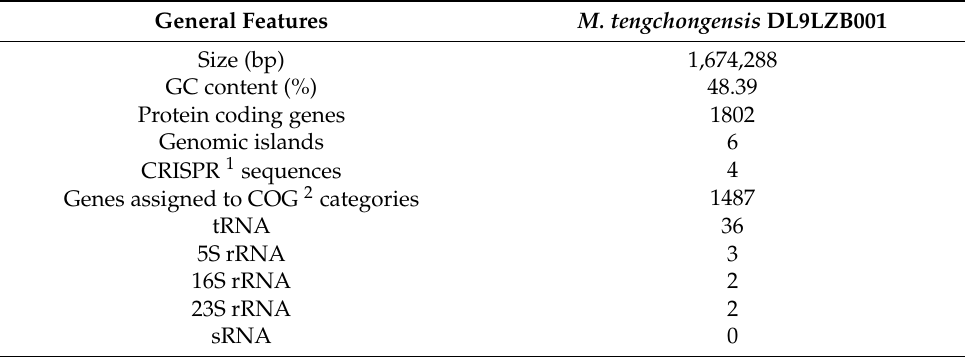
Table 2. General genome features of M. tengchongensis